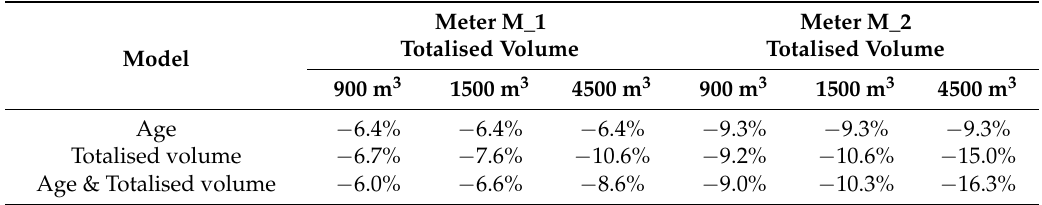
Meter M_2 Totalised Volume